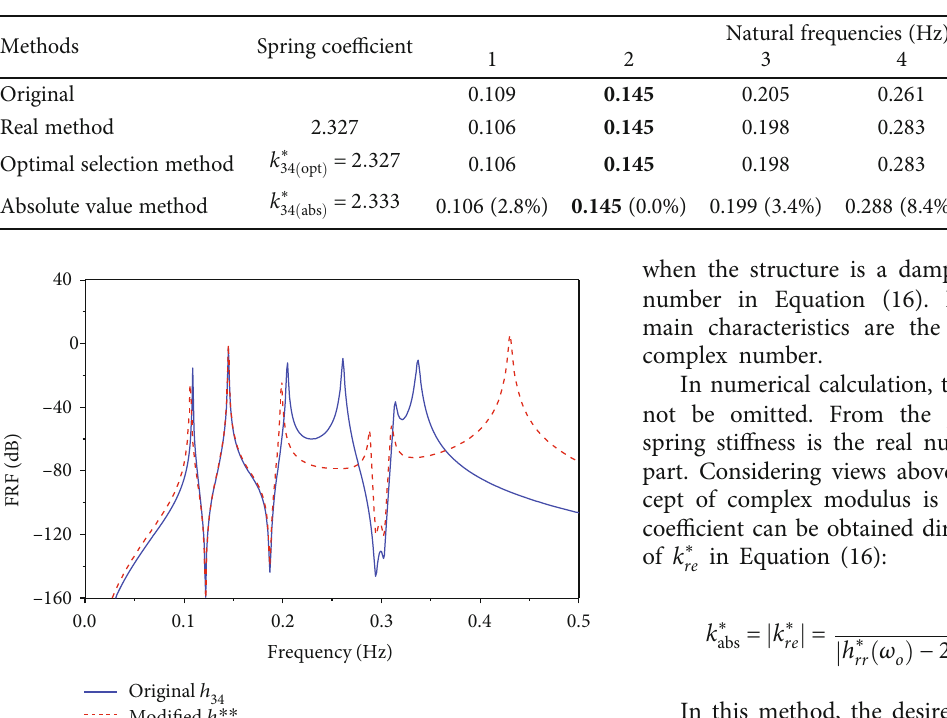
Table 2: Necessary spring coe ffi cient (N/m) and the natural frequencies.